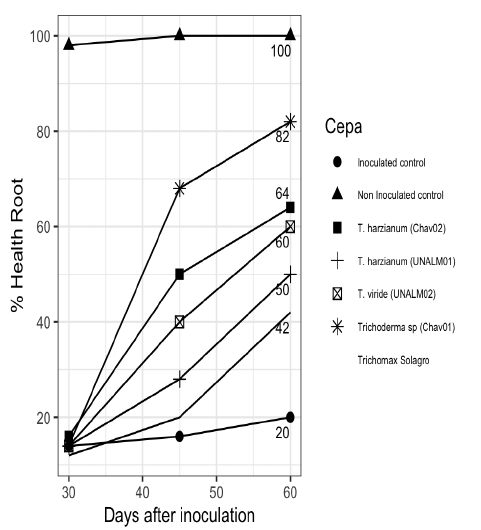
Fig. 3. Percentage of healthy roots treated with different Trichoderma strains in avocado seedlings inoculated with Phytophthora